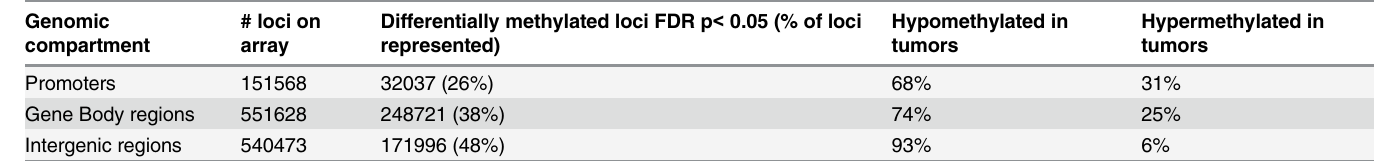
Table 1. Genomic distribution of DM sites. 452754 loci are significantly differentially methylated (DM) between T and NT based on an FDR < 0.05. Major- ity of the DM loci are hypomethylated in T vs NT. Genomic compartment